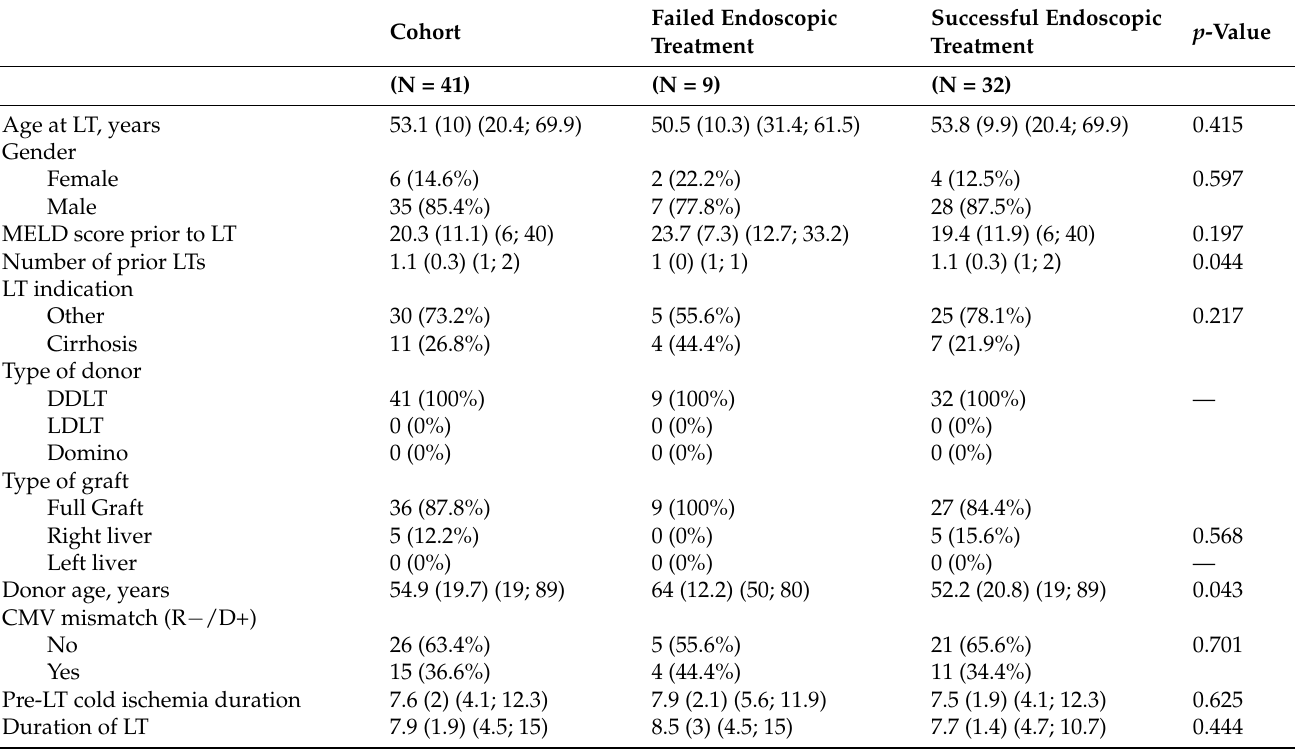
Table 1. Patient baseline